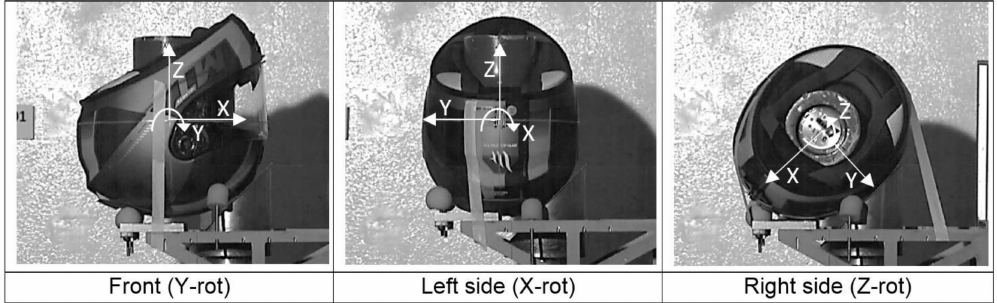
Figure 1. Oblique impact point layouts and coordinate